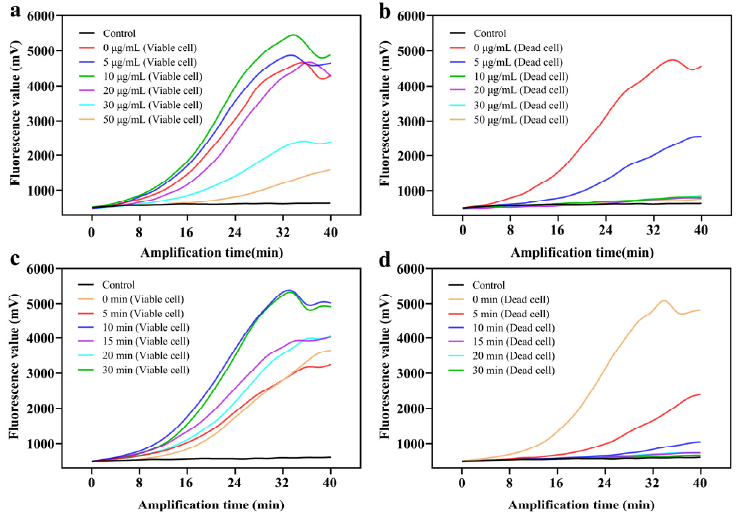
Figure 3. Optimization of reaction conditions. The fluorescence curve of ( a ) viable cells and ( b ) heat- killed dead cells subjected to TOMA treatment at 0, 5, 10, 20, 30, and 50 μ g/mL; the fluorescence curve of ( c ) viable cells and ( d ) dead cells after exposure for 0, 5, 10, 15, 20, and 30 min.